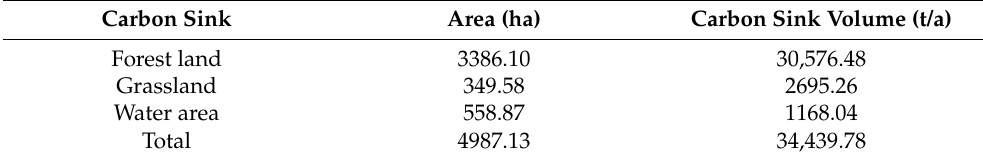
Table 3. Carbon sequestration in each carbon sink of urban green space in central Nanjing.